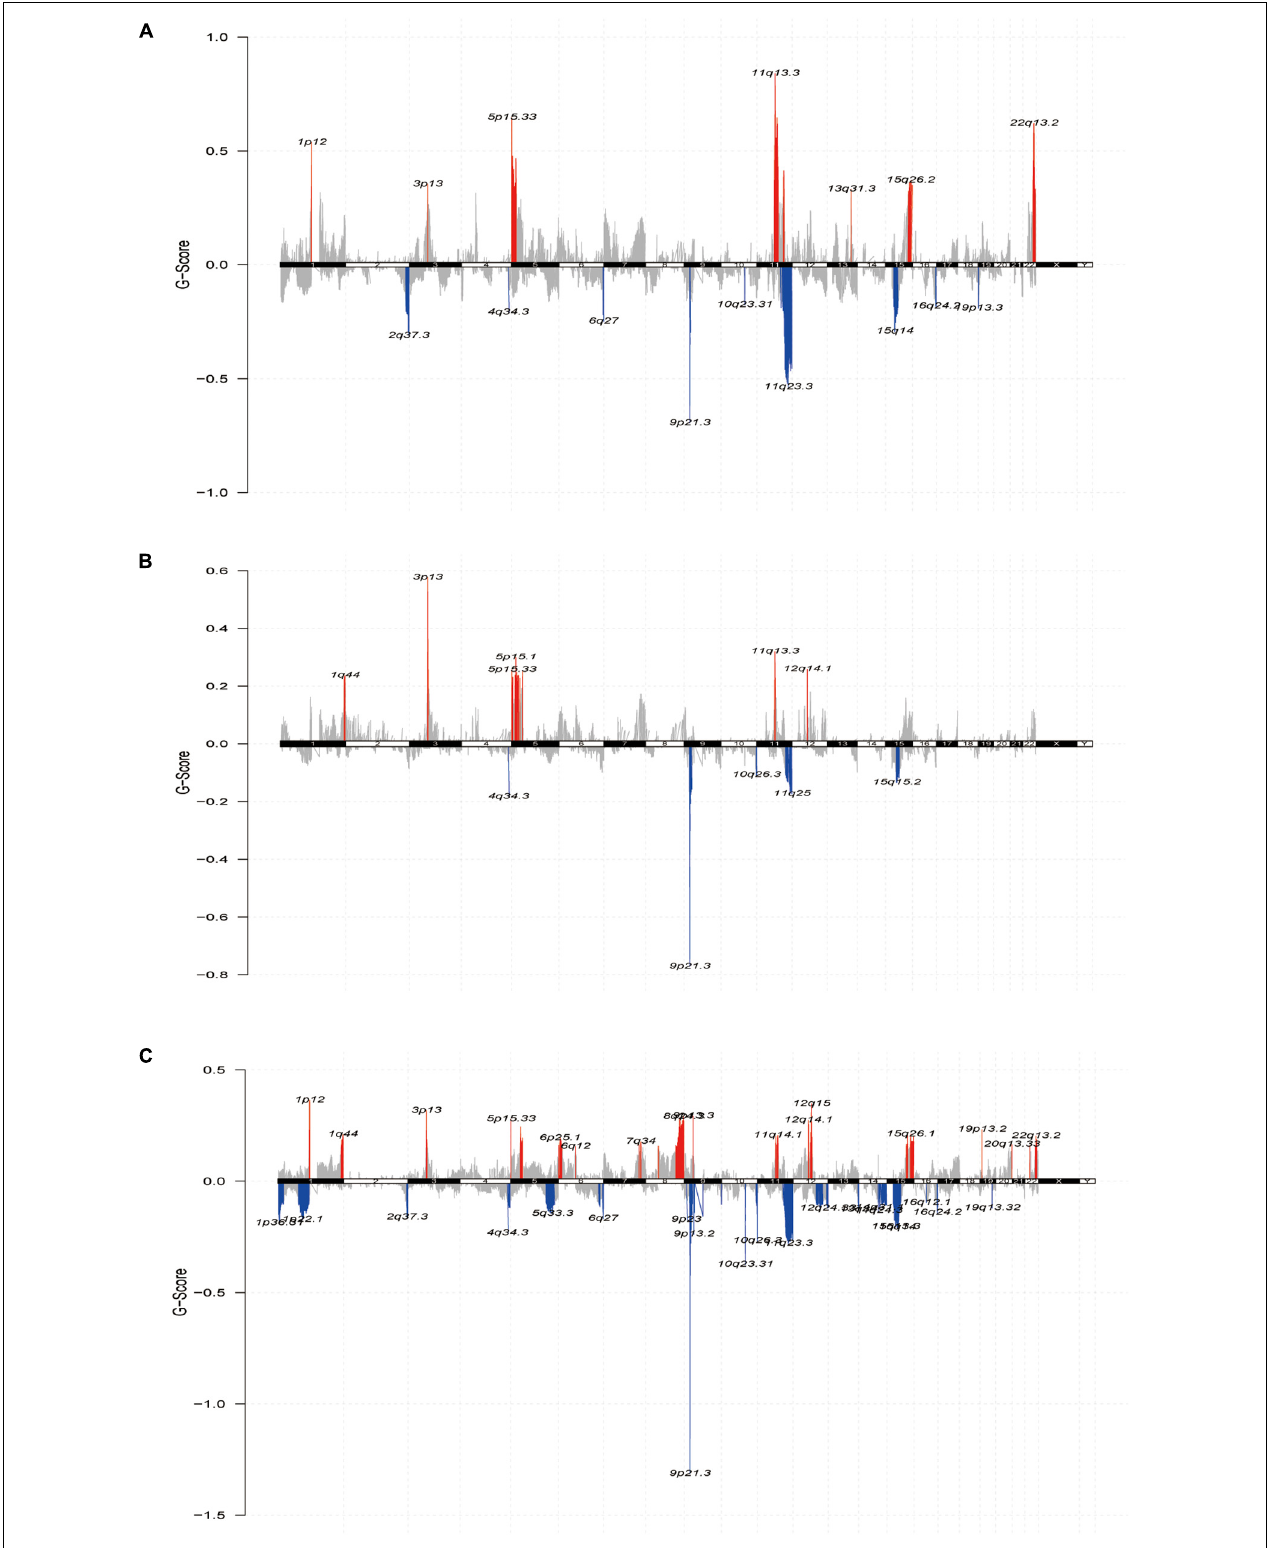
FIGURE 6 | The landscape of somatic copy-number alterations in the three subtypes. (A–C) Cytoband showed the genomic copy-number change from three subtypes. Amplification (red) and deletion (blue) of each regional peak are shown and highlighted.